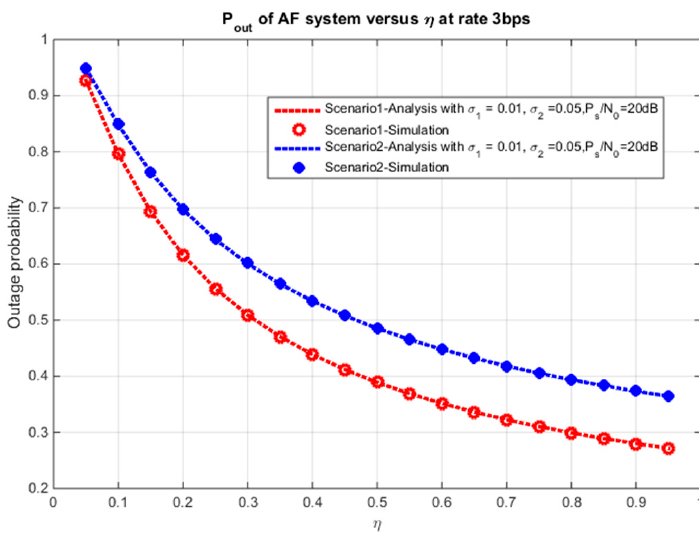
Figure 3. Outage probability versus η .